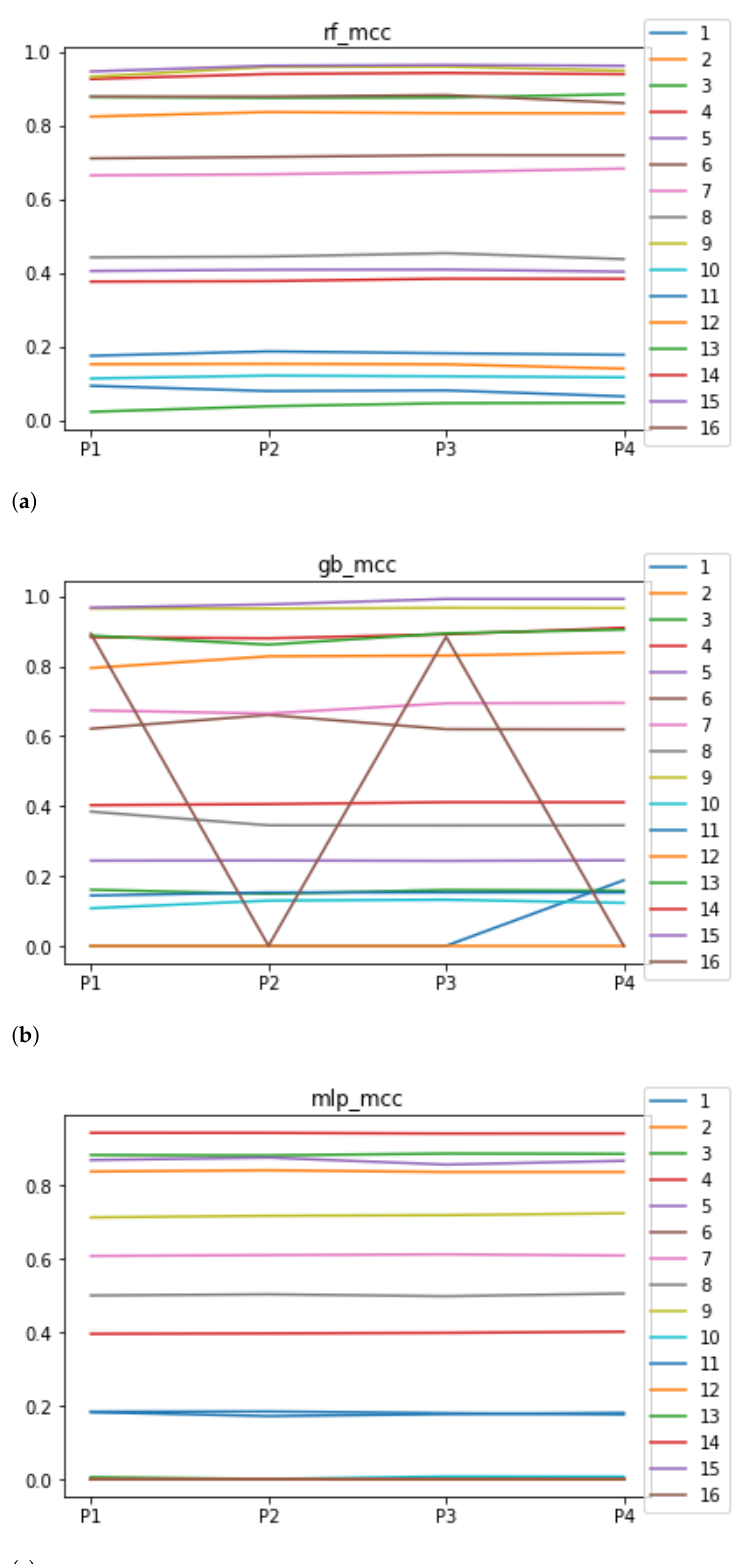
Figure 5. Behavior of RHOASo: MCC. Each line represents a dataset. ( a ) MCC for RF. Axis X: the partition of the dataset. Axis Y: the obtained MCC. ( b ) MCC for GB. Axis X: the partition of the dataset. Axis Y: the obtained MCC. ( c ) MCC for MLP. Axis X: the partition of the dataset. Axis Y: the obtained